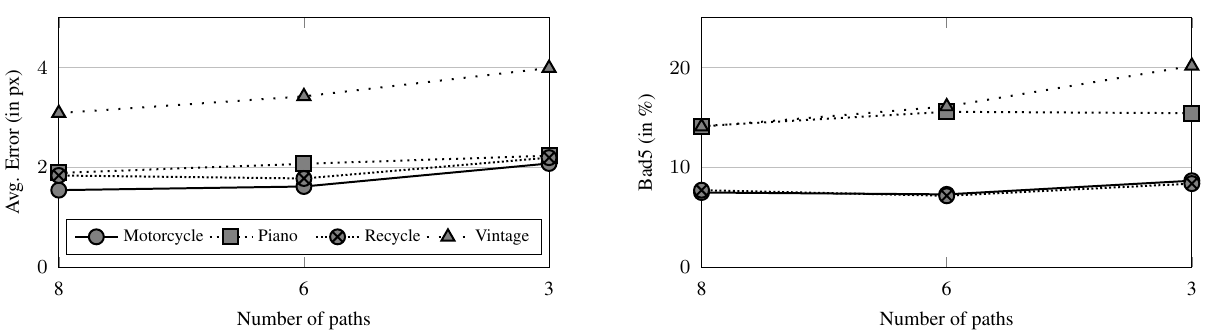
Figure 6. Effect of incorrect disparity bounds